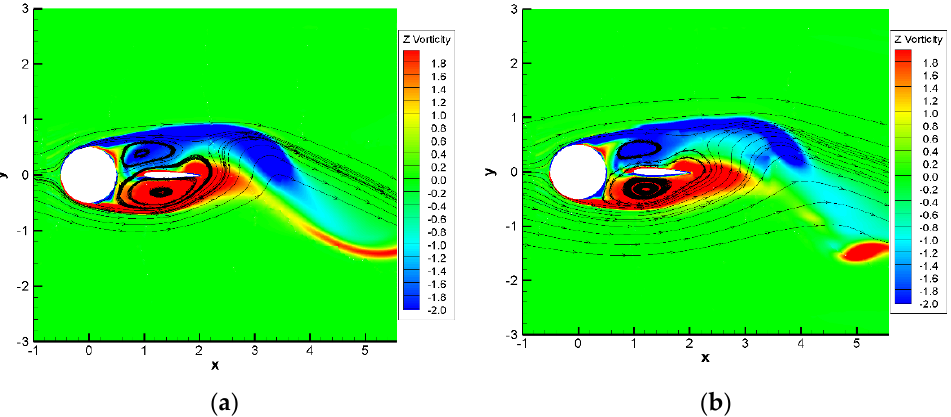
Figure 9. Vorticity contour at the moment of drag coefficient amplitude ( x / D = 1.0): ( a ) T / T 0 = 2.0; ( b ) T / T 0 = 5.0.